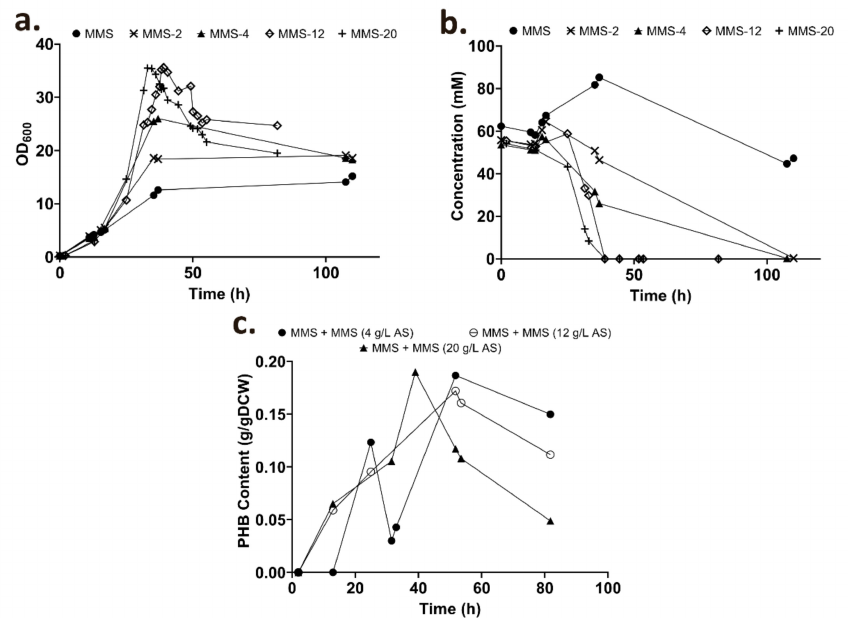
Figure 5. Growth of SOS3 in media supplemented with varying amounts of nitrogen. ( a ) Growth curves. ( b ) Sugar concentrations throughout. ( c ) PHB content over time of SOS3 cultures supplemented with varying amounts of nitrogen.